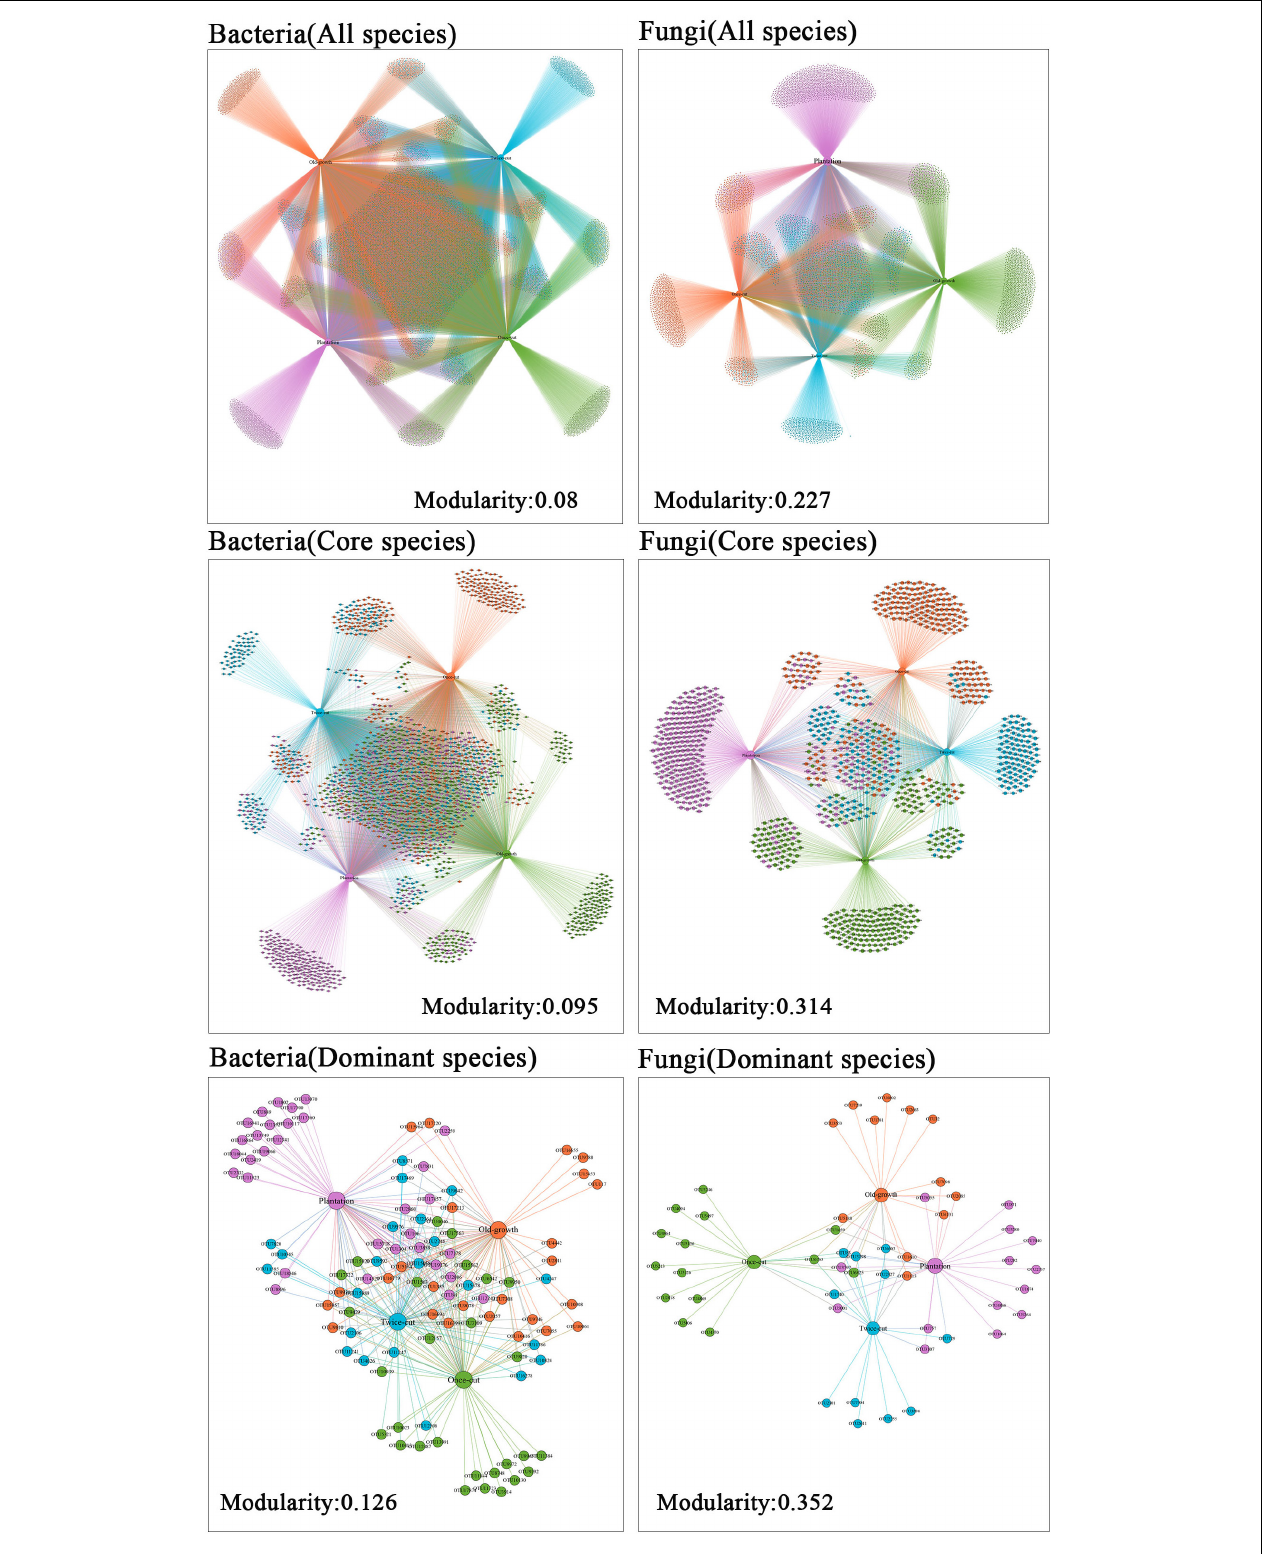
FIGURE 3 | Network analysis of dominant OTU of bacteria and fungi in the four forest succession. The size of the node indicates the richness of the species. The colors of node indicate the distribution of OTUs in different succession.